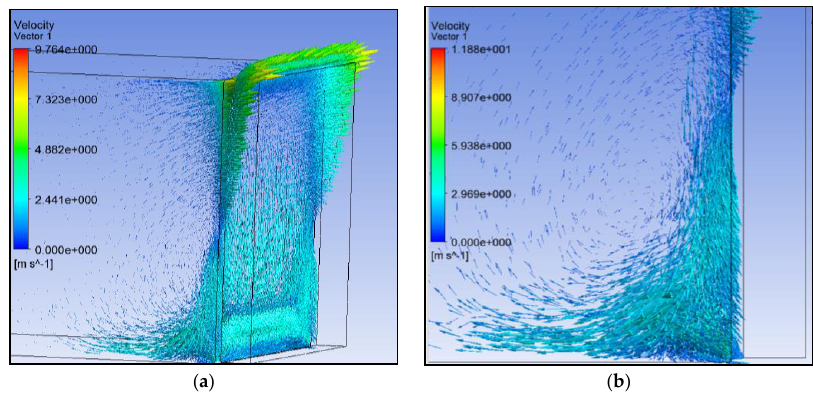
Figure 6. Velocity vectors of the gases for an opening of 3 cm: ( a ) Velocity vectors and formation of convective motion; ( b ) Particular of convective motion at the bottom of the furnace.